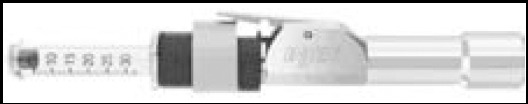
Needle-free injection system; INJEX™ model 210.